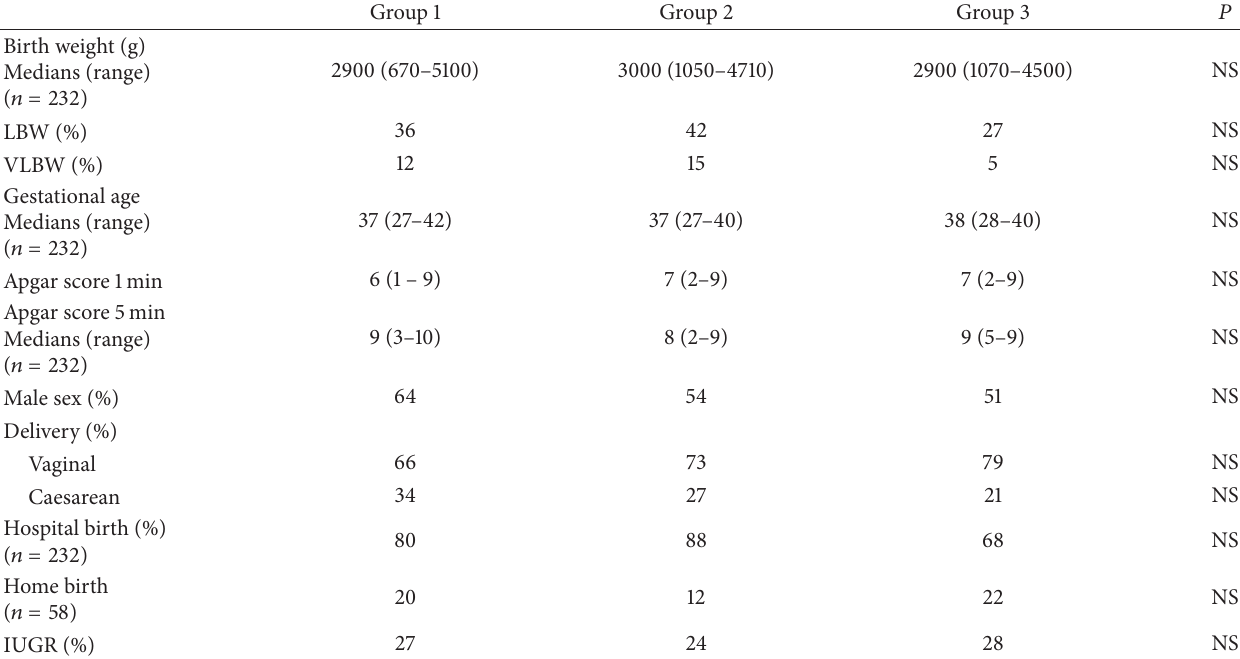
Table 1: Perinatal data of the three groups 𝑛 = 290 . LBW (low birth weight); VLBW (very low birth weight) IUGR (intrauterine growth restriction).